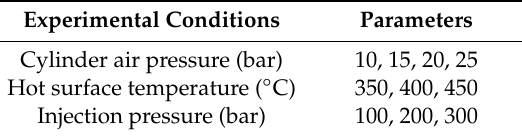
Table 6. Experimental conditions.